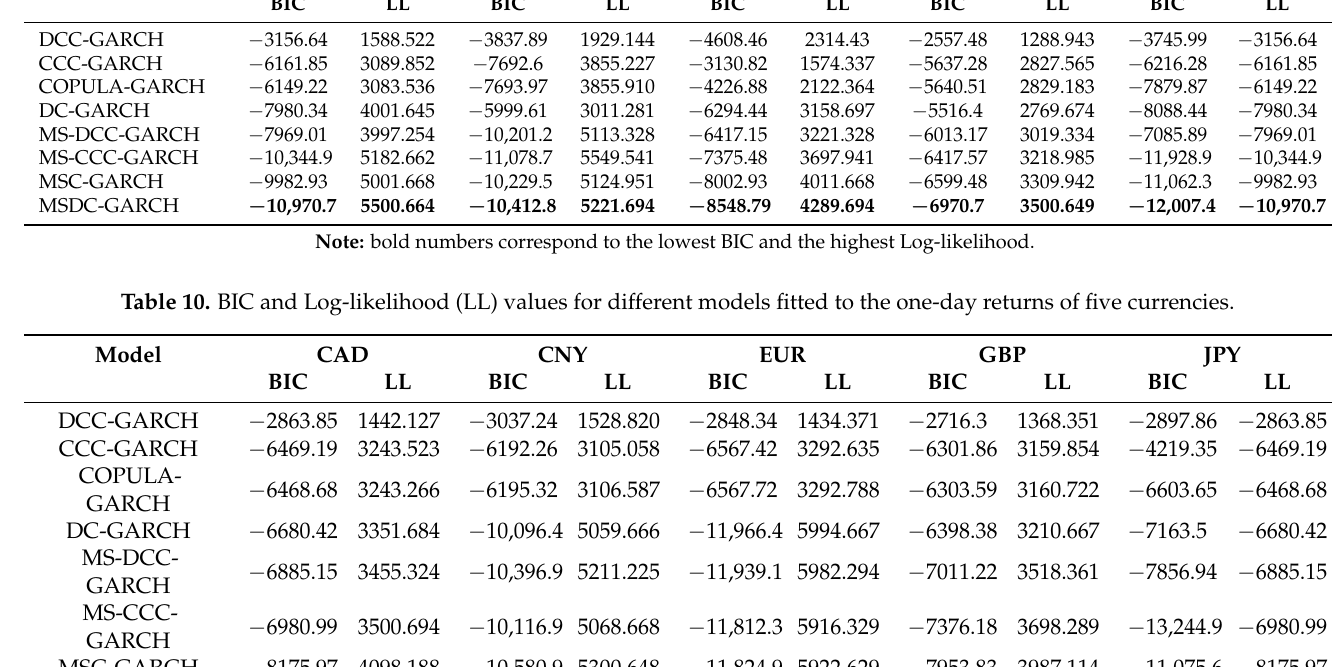
Table 9. BIC and Log-likelihood (LL) values for different models fitted to the 60-min returns of five currencies. Model